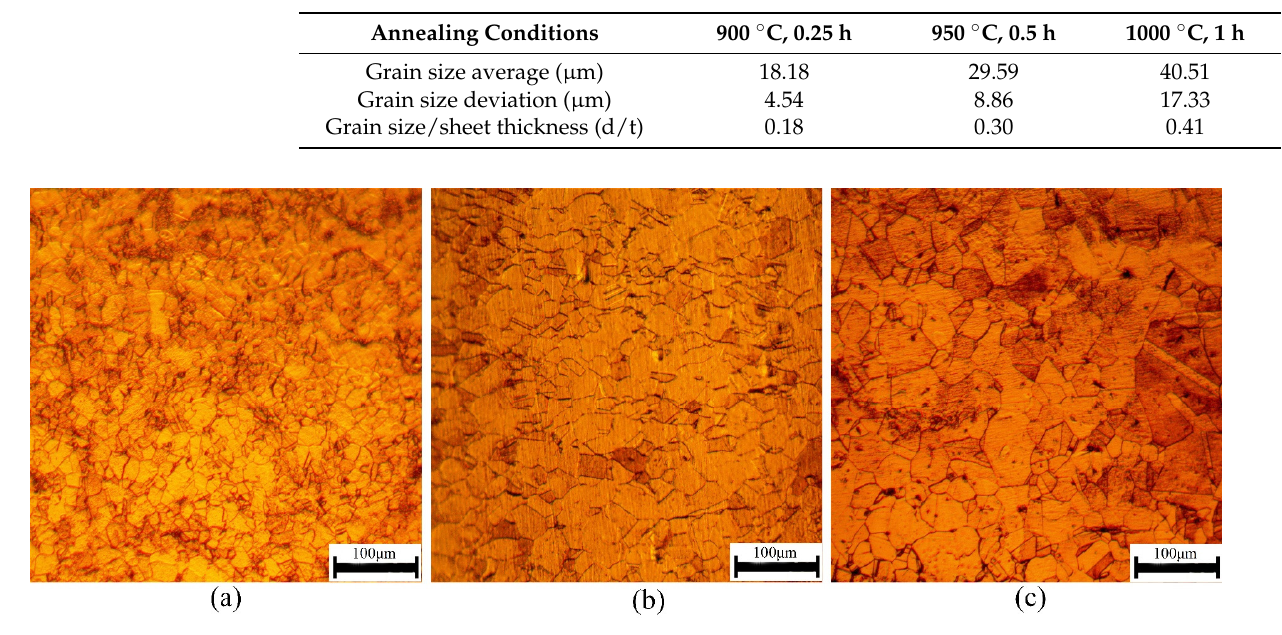
Table 1. Heat-treatment parameters and the corresponding grain sizes.